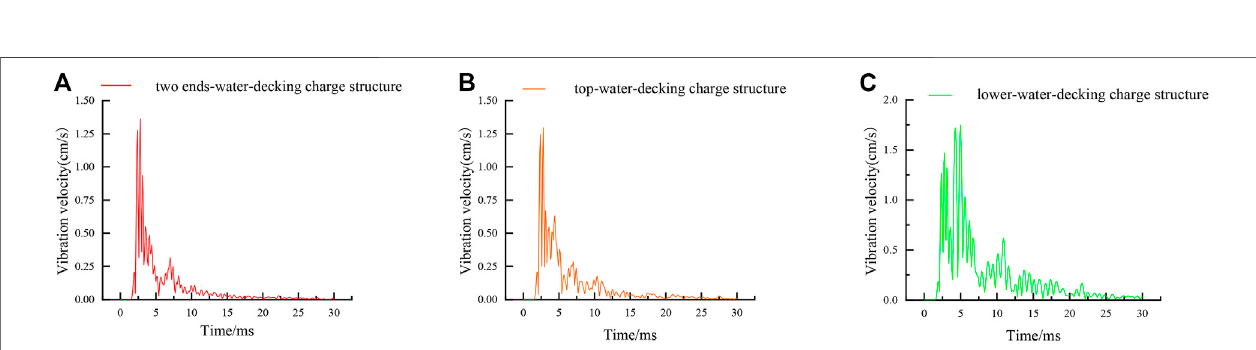
FIGURE10| TheresultantvibrationvelocityresponseofLine3underdifferentchargestructureconditions. (A) Twoends-water-deckingchargestructure. (B) Top- water-decking charge structure. (C) Lower-water-decking charge structure.